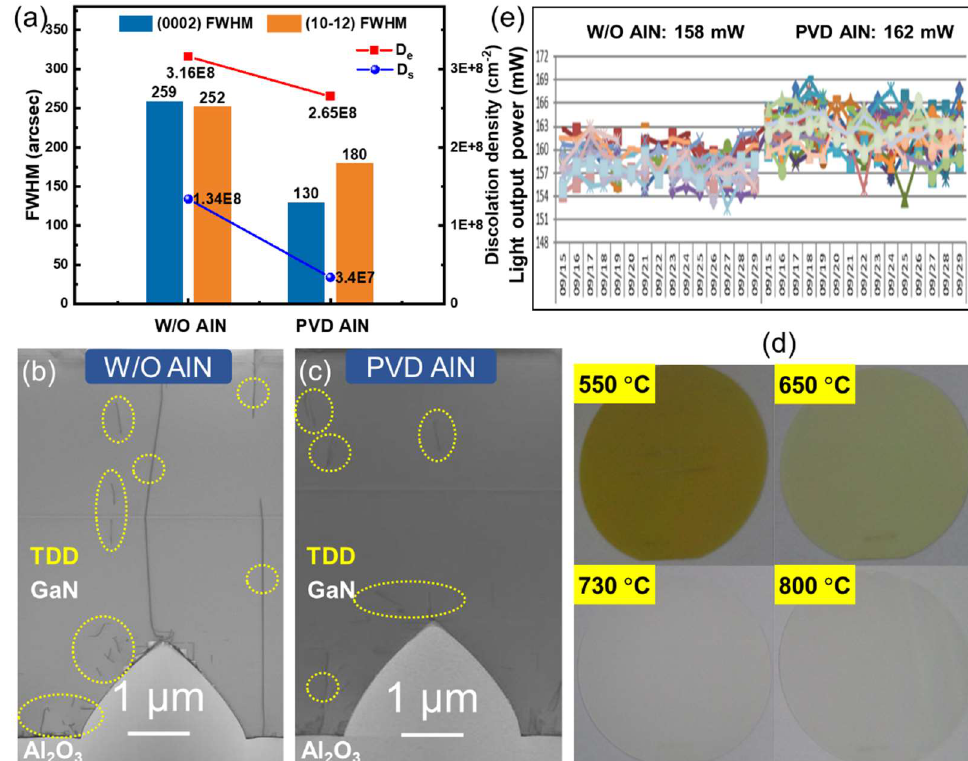
Figure 3. ( a ) The mean FWHM values of (0002) and (10–12) rocking curves of epitaxial wafers utilizing W/O AlN and PVD AlN prebuffer, D s : screw TDD, D e : edge TDD; TEM images of BLED epilayers using ( b ) W/O AlN, ( c ) PVD AlN prebuffer; ( d ) The optical photo of the wafers, in which the GaN buffer layer was grown at 550, 650, 730, and 800 ◦ C using PVD AlN prebuffer. ( e ) ϕ e data logging results of mass production wafers using W/O AlN and PVD AlN prebuffer for half a